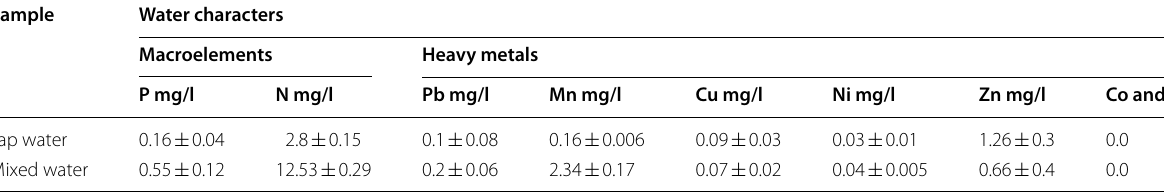
FAO *: Food and Agricultural Organization Table 2 Water analysis of macroelements and heavy metals in tap water (control) and mixed wastewater